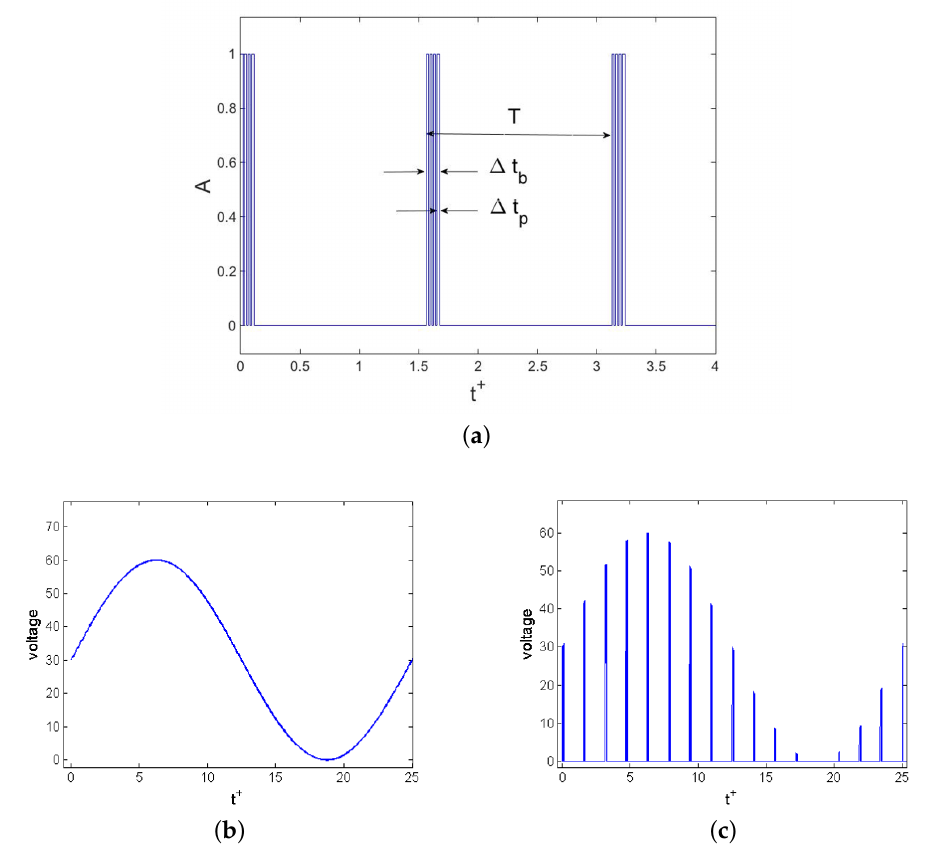
Figure 2. The actuator input signals. ( a ) The carrier wave, ( b ) the low-frequency control signal and ( c ) the combined actuator input signal.